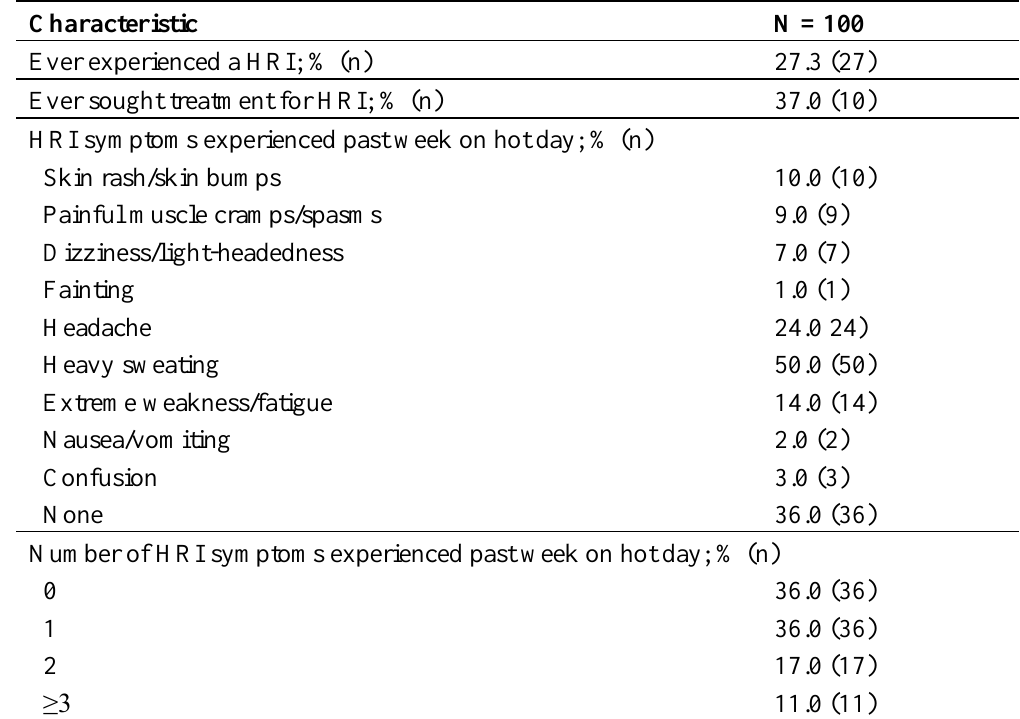
Table 2. Frequency of heat-related illness experienced among study participants, Oregon, 2013.